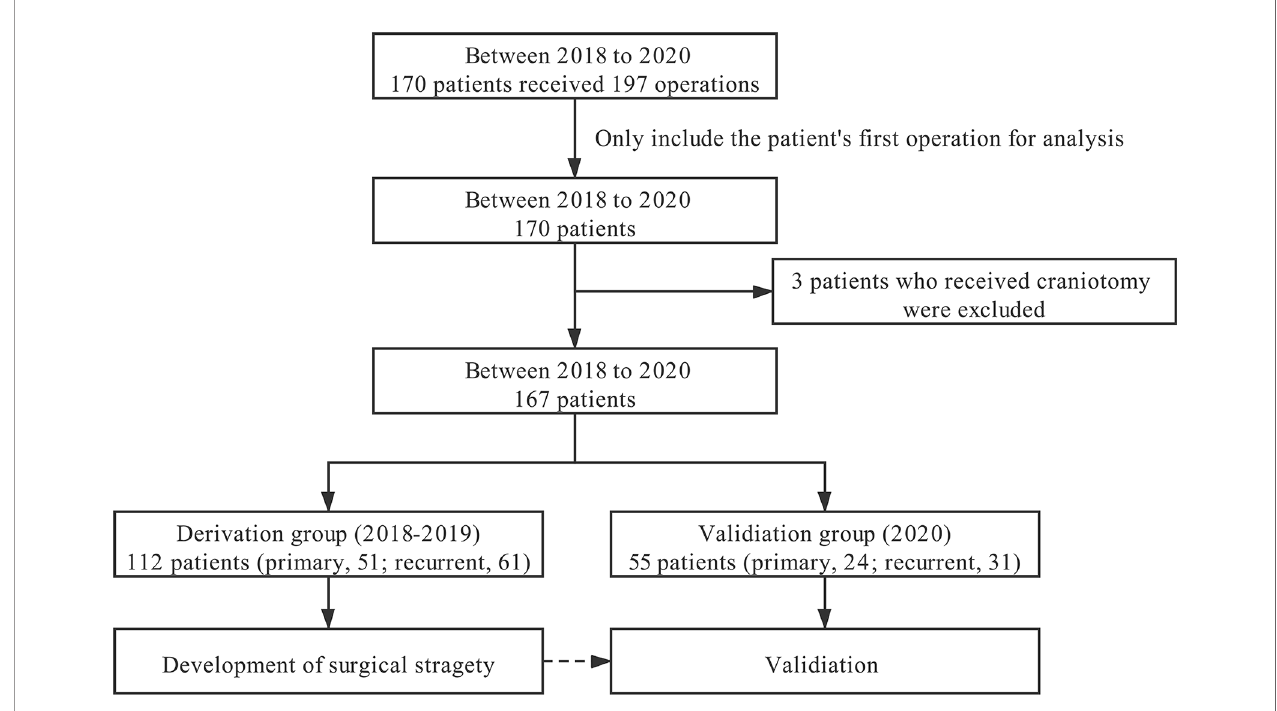
FIGURE 6 | Flowchart for patient selection.